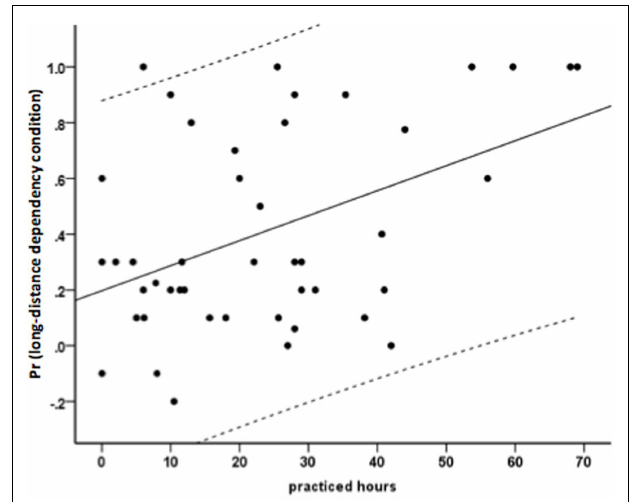
FIGURE 3 | Relationship between cumulated hours of musical training until 19 and the achieved level of syntax proficiency (measured as Pr) for the long-distance dependency condition. There is a significant positive correlation between the two variables ( r =0.46, p <0.01, indicated by the solid line).The dashed lines indicated the 95% confidence interval.